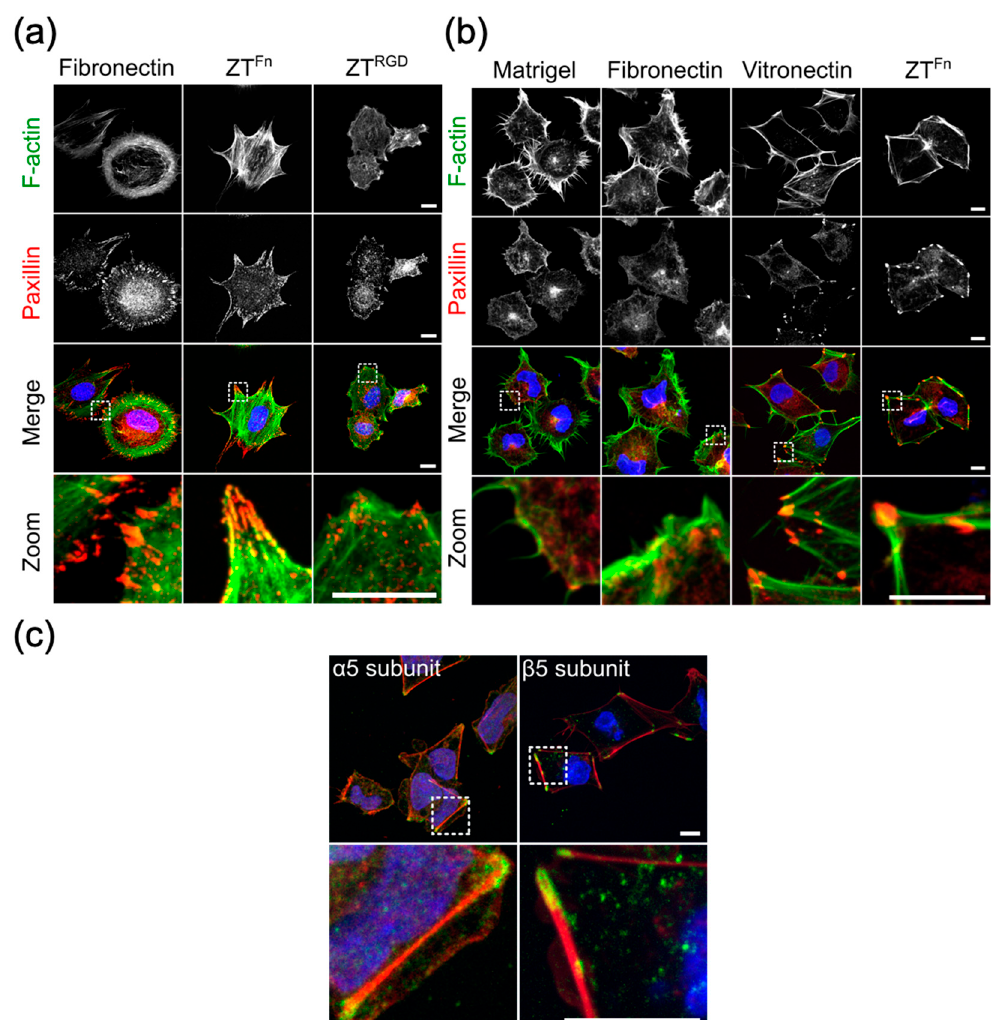
Figure 5. Culturing of murine mesenchymal stromal cells (mMSCs) and human embryonic stem cells (hESCs) on the ZT Fn polymer. Focal adhesion formation and cytoskeletal organization in mMSCs and hESCs cultured on different substrates. Immunofluorescence micrographs show representative z-series projections of mMSCs ( a ) and hESCs ( b ) cultured on ZT variants and control substrates. Cells were stained for F-actin (green), paxillin (red), and DAPI (blue). Zoomed views of the boxed areas in the upper panels are shown to highlight focal adhesions and cytoskeletal structures. ( c ) hESC integrin engagement on ZT Fn . Immunofluorescence micrographs show hESCs cultured on ZT Fn and stained for F-actin (red), α 5 or β 5 integrin subunits (green), and DAPI (blue). Zoomed views of the boxed areas in the upper panels are shown to highlight integrin staining. Scale bars = 10 µm.